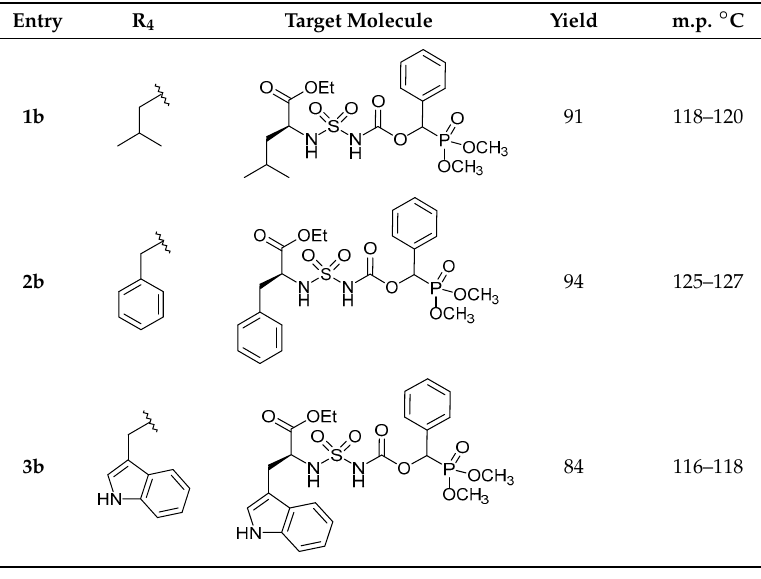
Table 2. Physical data and yields for sulfamidocarbonyloxyphosphonates 1b – 3b synthesized from amino acid esters.